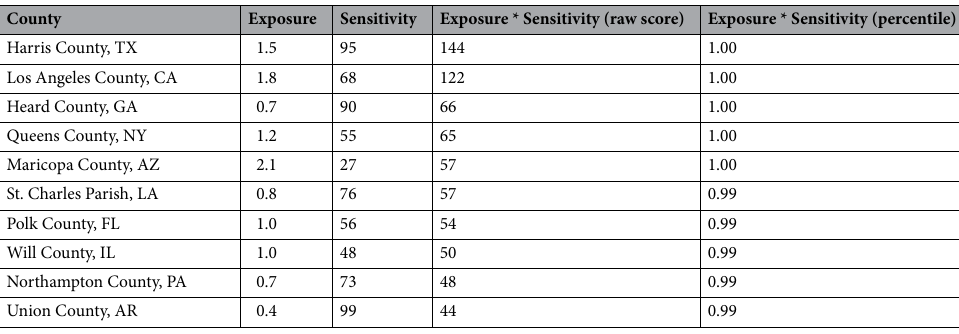
Table 1. Exposure, sensitivity, and exposure times sensitivity scores for the top 10 counties across all six fossil fuel categories. Notes: Exposure is reported on a scale of zero to 100, where 100 indicates that a given county accounts for 100 percent of the relevant fossil fuel activity (e.g., coal extraction) nationwide. Sensitivity scores are also reported on a scale of zero to 100, but differ from the exposure metrics by indicating each county’s percentile of all US counties based on the metrics for defining a “disadvantaged” community (see “Methods”). Aggregate scores are reported in two ways. The first presents the raw product of exposure times sensitivity, and the second ranks each county by percentile of all US counties with the relevant fossil fuel